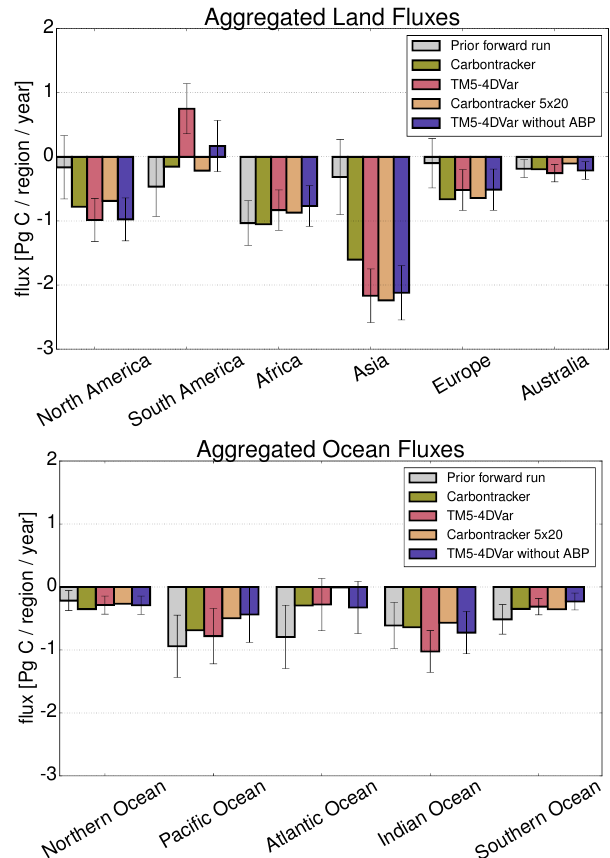
Figure 8. Fluxes from TM5-4DVar and CarbonTracker aggregated on continental scale. The uncertainties for TM5-4DVar are calcu- lated following Basu et al. (2013). The error bars for the prior are taken from TM5-4DVar. As written in Sect. 5.1 we show no uncer- tainties for CarbonTracker, because the aggregation of uncertainties from the weekly to yearly scale is not clearly